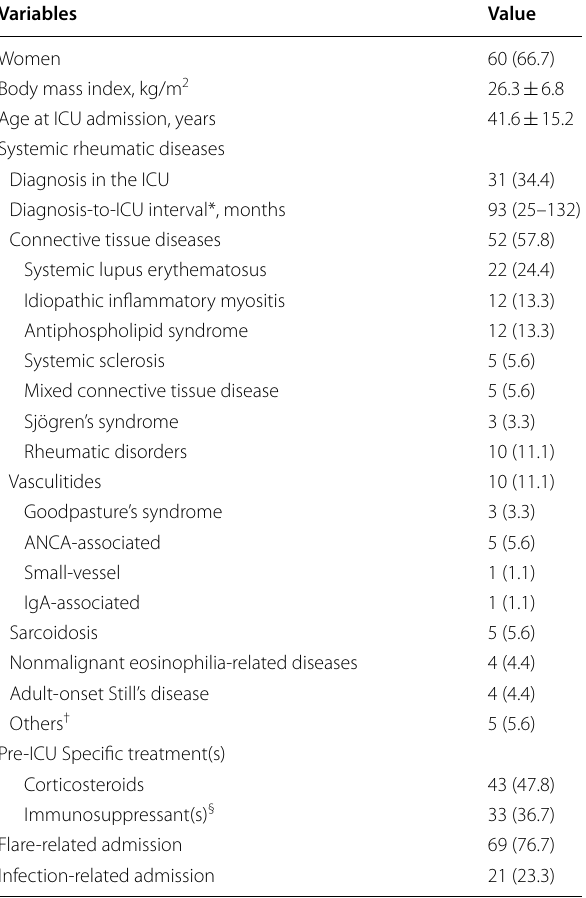
Table 1 Characteristics of 90 SRD patients given ECMO